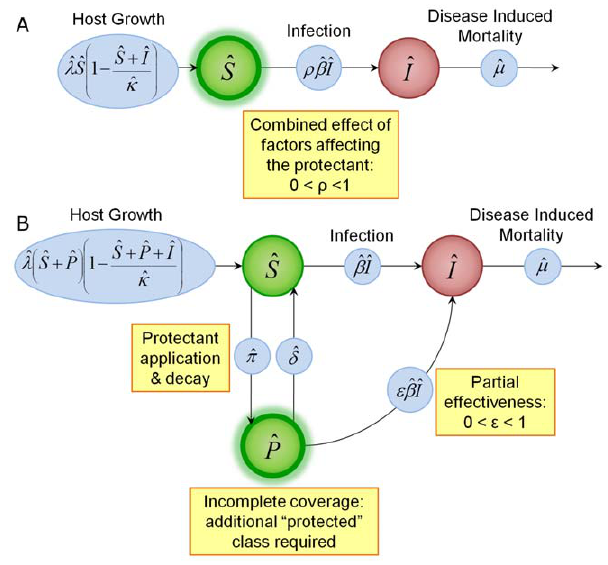
Figure 1. Model transtion diagrams. (A) The conventional model (the ‘implicit’ model) incorporates fungicide dynamics implicitly and therefore assumes uniform, permanent coverage by the protectant. (B) The model with explicit fungicide dynamics (the ‘explicit’ Model) allows for partial coverage and decay in activity of the protectant as well as different infection rates depending on whether the hosts have a protectant fungicide applied or not. The variables and parameters are explained in Table 2.